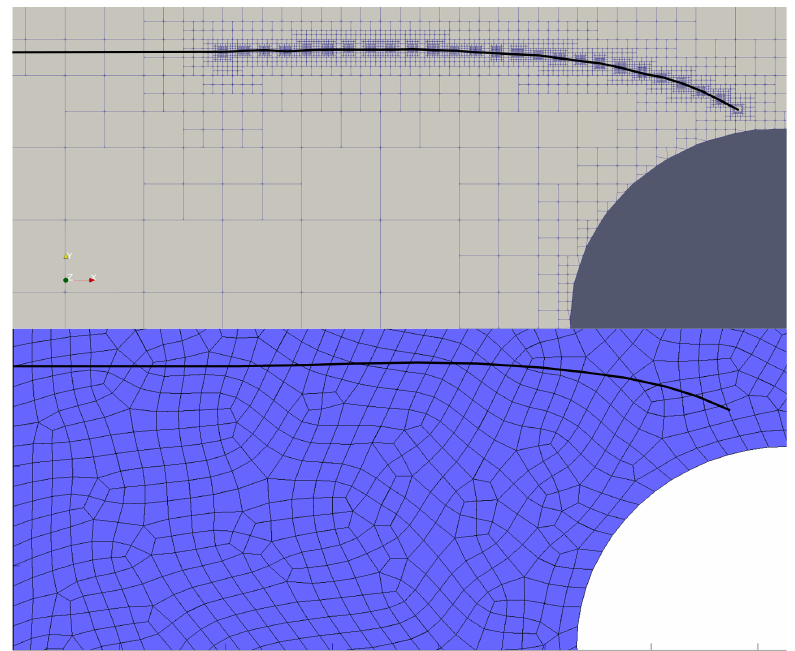
Figure 26. NPwH meshes for SBFEM ( top ) and XFEM ( bottom ), with focus on crack path region. The last crack propagation step prior to the cracks reaching the hole is depicted.